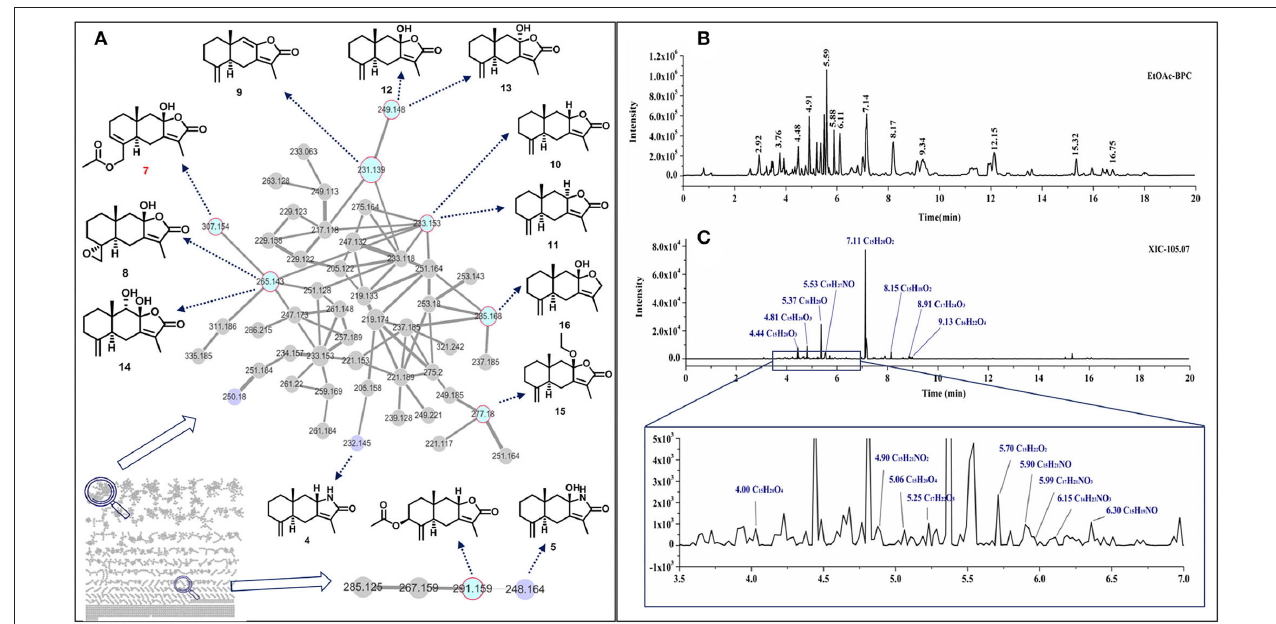
FIGURE 1 | Sesquiterpenoids discovery in the rhizome of AM by GNPS and metabolic profiling analysis. GNPS analysis of AM methanol extract ethyl acetate extract layer. Blue nodes represented compounds that have been identified, purple nodes represented nitrogen-containing sesquiterpenoids, gray nodes remained unknown